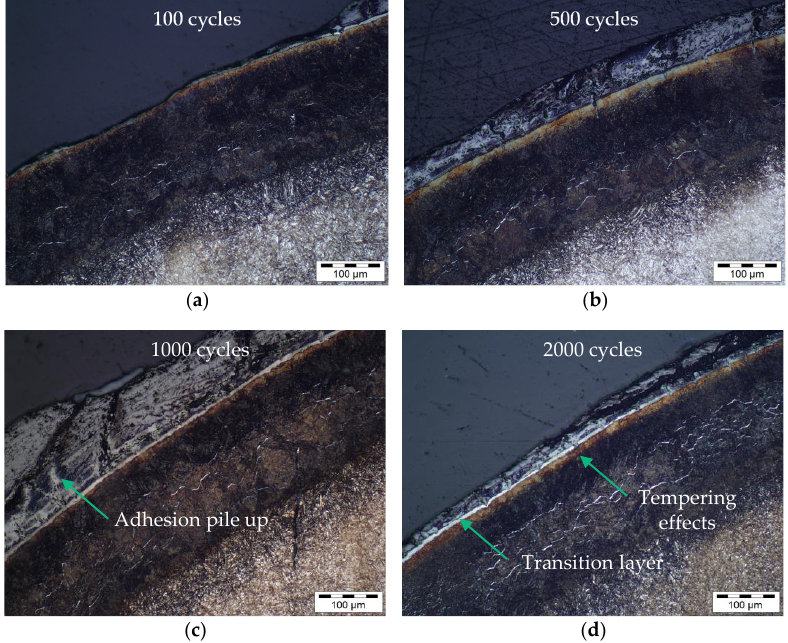
Figure 20. Metallographic cross-section at validation point G2 after ( a ) 100 cycles, ( b ) 500 cycles, ( c ) 1000 cycles and ( d ) 2000 cycles.